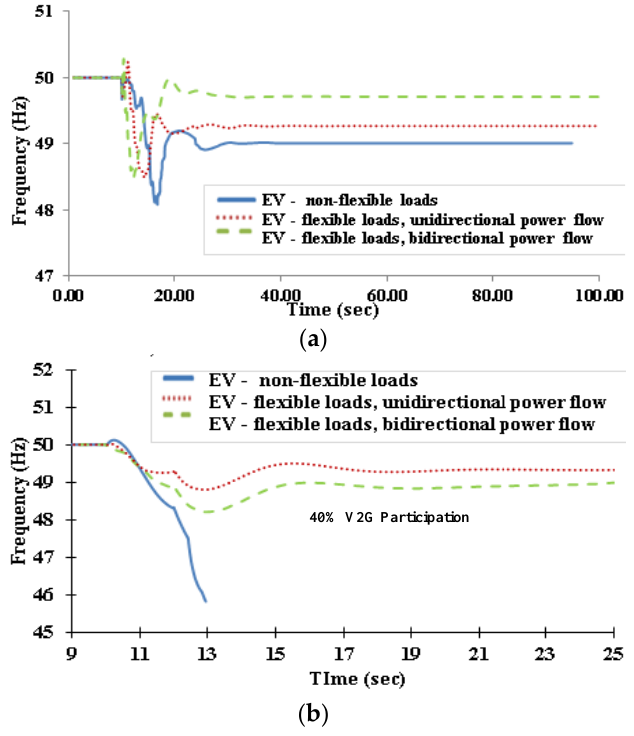
Figure 6. Simulation of ( a ) a three-phase short circuit at a high-voltage bus and ( b ) a three-phase short circuit at a high-voltage bus with simultaneous loss of two generators in the Greek non-interconnected island of Crete [16].